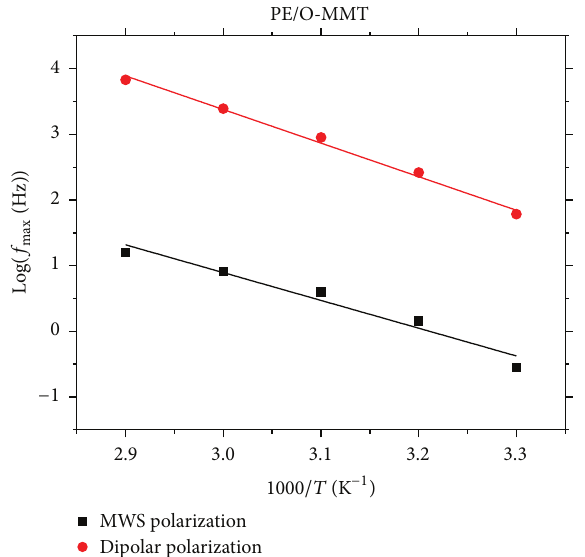
Figure 11: Relaxation rate 𝑓 max as a function of inverse temperature for the MWS relaxation rate observed in PE/O-MMT and PE/O- MMT/PE-MAnanocomposites.Thesolidlinesrepresentbestfitsfor the Arrhenius